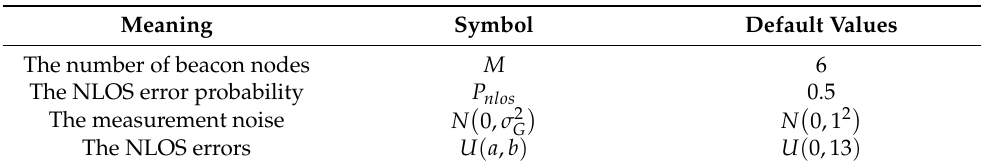
Table 2. Uniform distribution parameter.